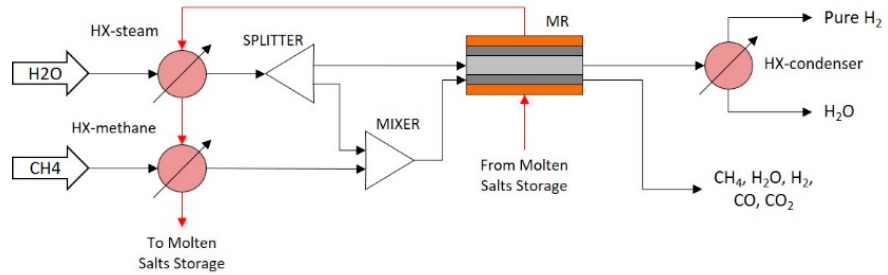
Figure 2. Integrated membrane reactor flowsheet configuration (IMR).